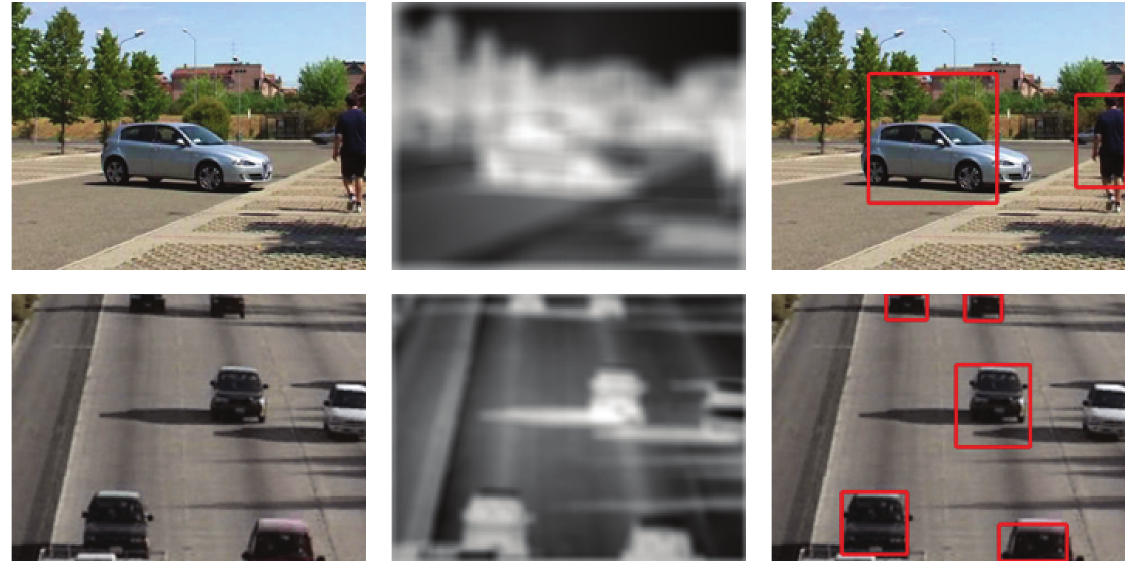
Figure 4: Videos (1) and (2): results using modified frequency tuned spatial model I.